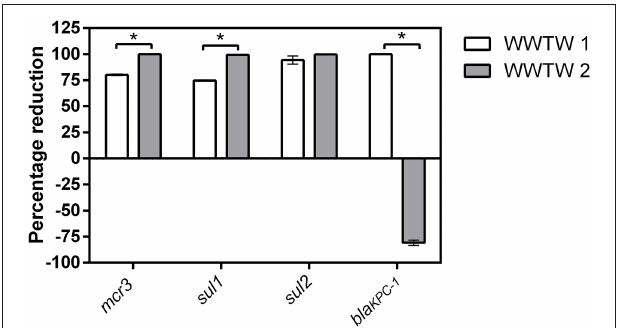
FIGURE 1 | Percentage reduction of target antibiotic resistance genes from influent to effluent in two WWTW. Significant differences ( p < 0.05) in percentage reduction between WWTW, identified using a t -test, are shown by the asterisk